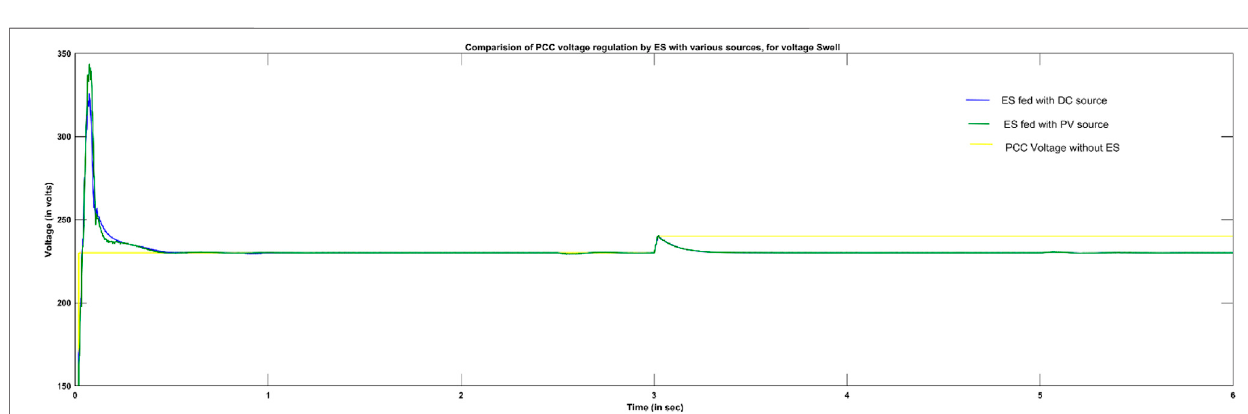
FIGURE 9 | Comparison of voltage regulation for voltage swell.